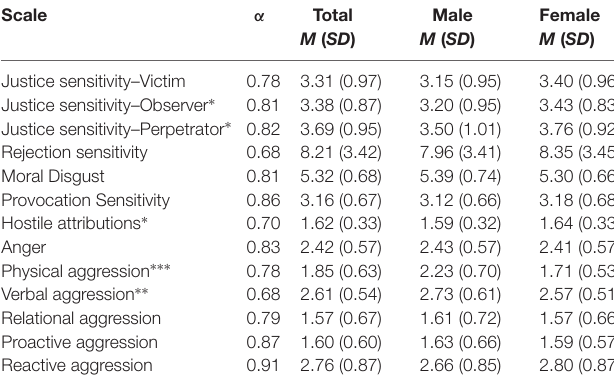
TABLE 2 | Descriptive statistics and gender differences. Scale α Total